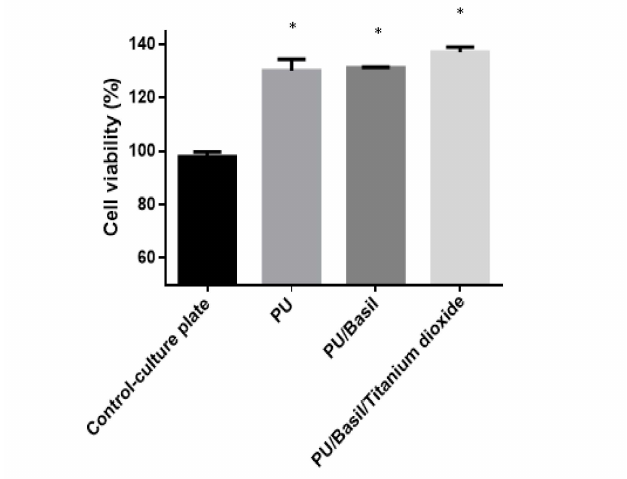
Figure 14. MTS assay PU, PU / BASIL and PU / BASIL / TiO 2